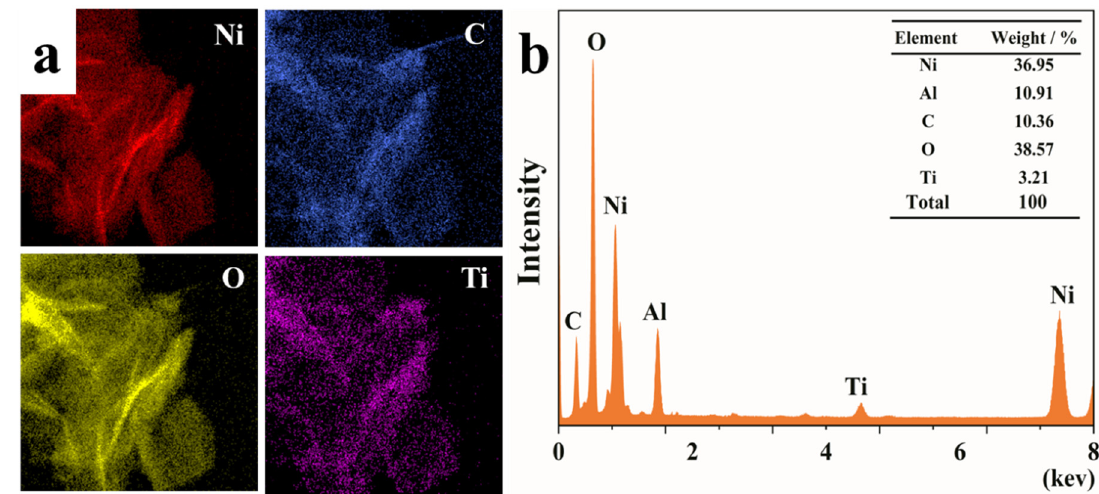
Figure 4. ( a ) EDS map-scanning and ( b ) EDS spectrum of LDHs@TA-Ti.